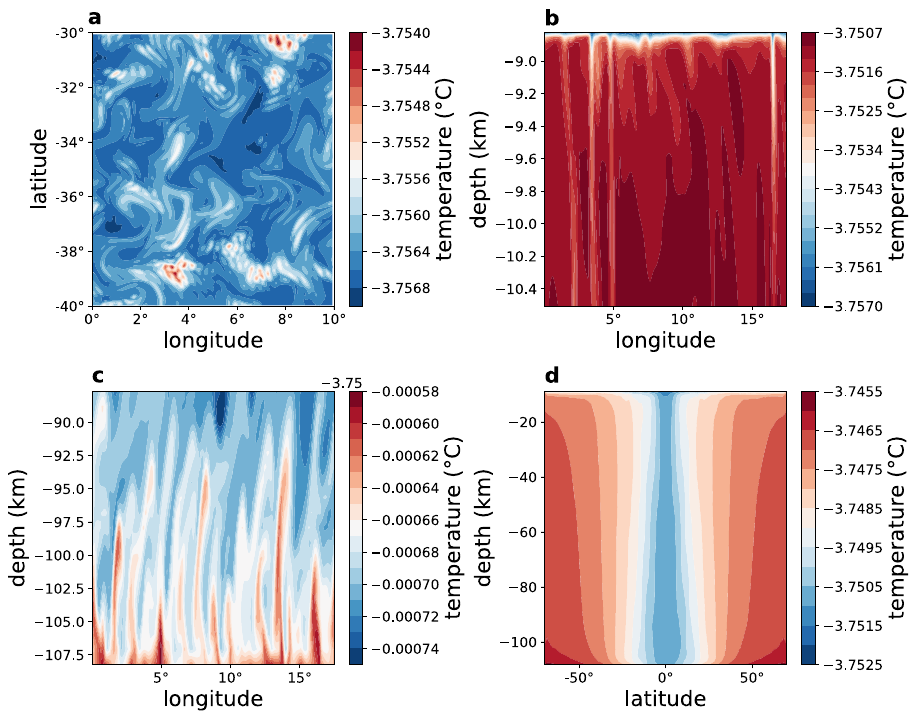
Fig. 4 Results of the 3d simulation — temperature. a Surface ocean temperature (°C) as a function of longitude and latitude for a 10 × 10° region, showing a highly turbulent fl ow. b , c Depth-longitude temperature (°C) sections near the top and bottom of the ocean at the equator, showing downward and upward convection plumes. At the equator, the local vertical (depth) direction is perpendicular to the Taylor columns, and the panels therefore demonstrate that convection does not necessarily occur along the Taylor columns. d Latitude-depth plots of zonal mean temperature